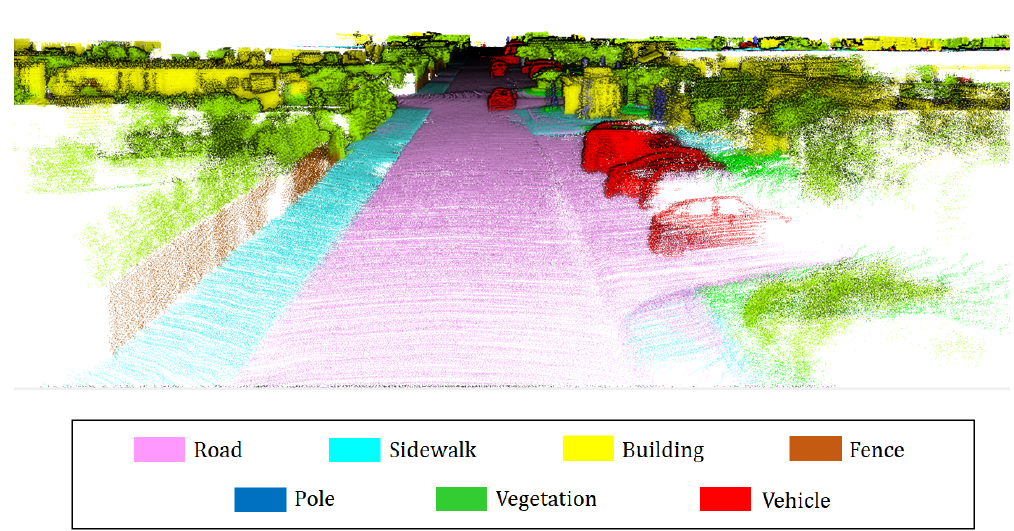
Figure 1. Example of a semantic 3D map generated by the proposed